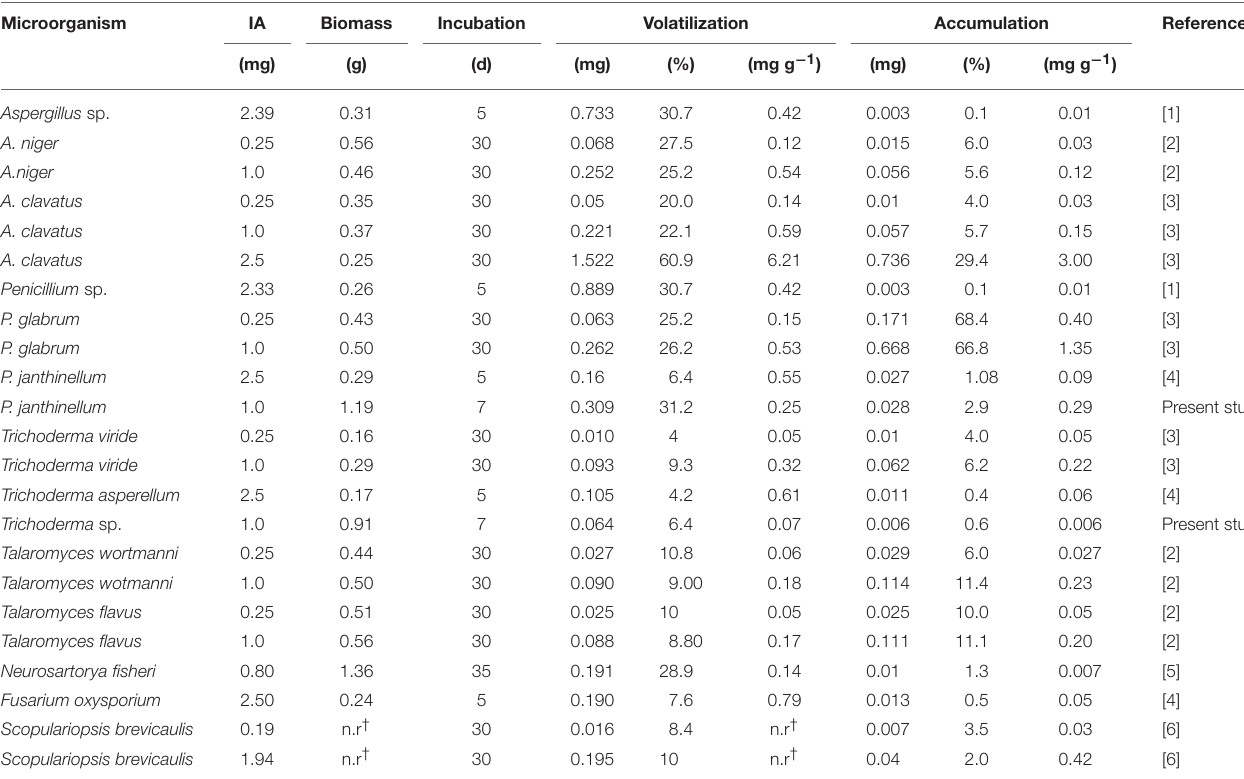
TABLE 4 | Comparative mass balance of As volatilization and accumulation in liquid cultures of fungal strains as a function of absolute amounts of the metalloid and exposure time. Microorganism IA Biomass Incubation Volatilization Accumulation